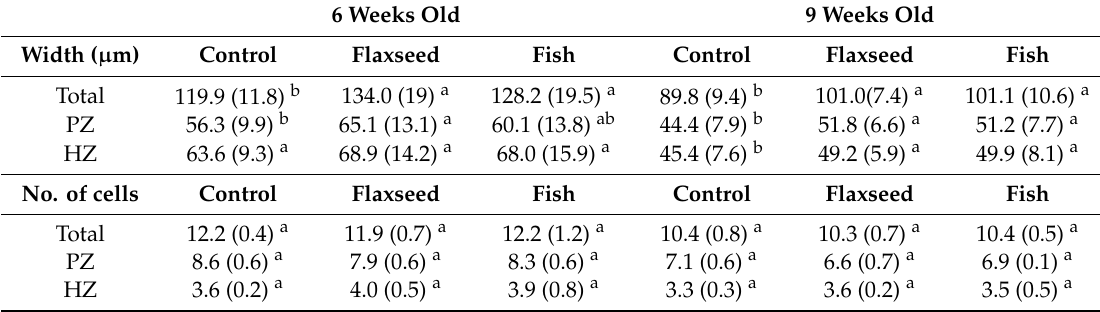
Table 5. Measurement of GP width and number of cells.